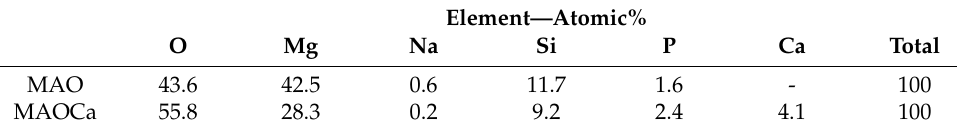
Table 1. EDS analysis of the different MAO-coated samples on ZK60 Mg alloys.